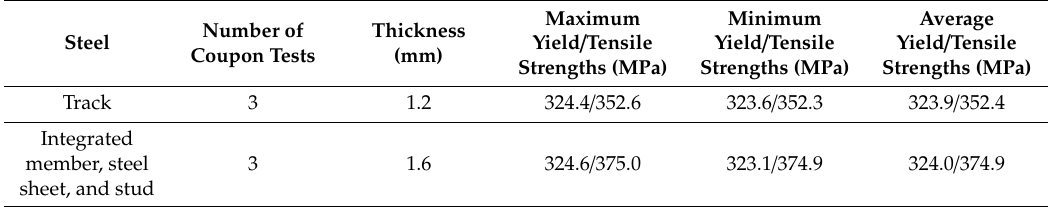
Table 2. Yield and tensile strengths of cold-formed steel (CFS) components of the integrated panel.